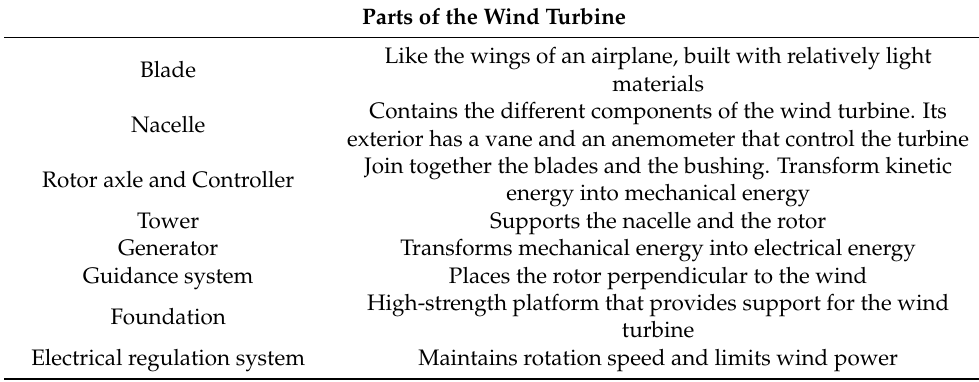
Table 6. Definitions of the parts of a wind turbine.